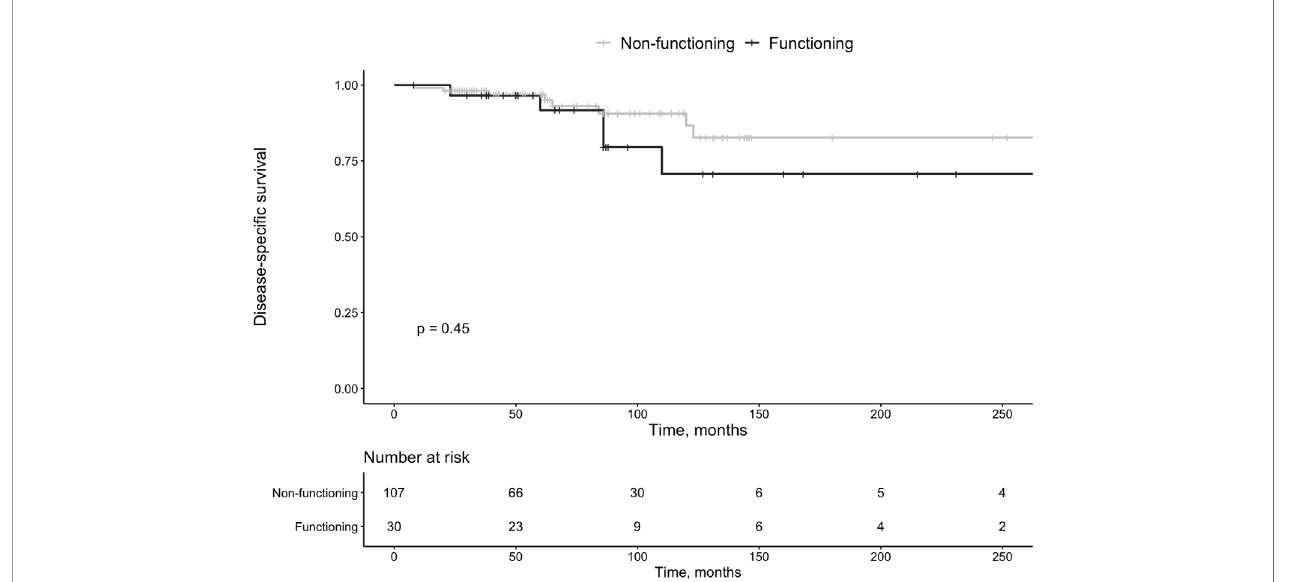
FIGURE 3 | Survival in patients with functioning vs. non-functioning